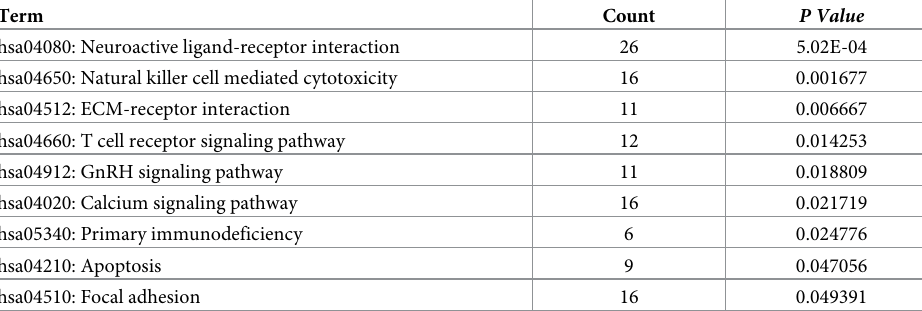
Table 5. KEGG enrichment using down-regulated